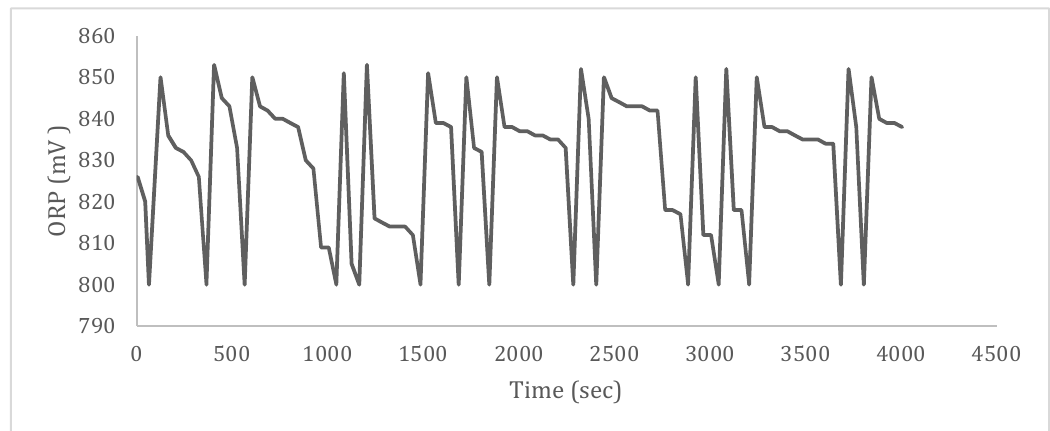
Figure 6. ORP change by starting and stopping ACD in water purification and disinfectant system for five consecutive days. Manual ORP Detection of Water Quality at the Clinic System Outlet